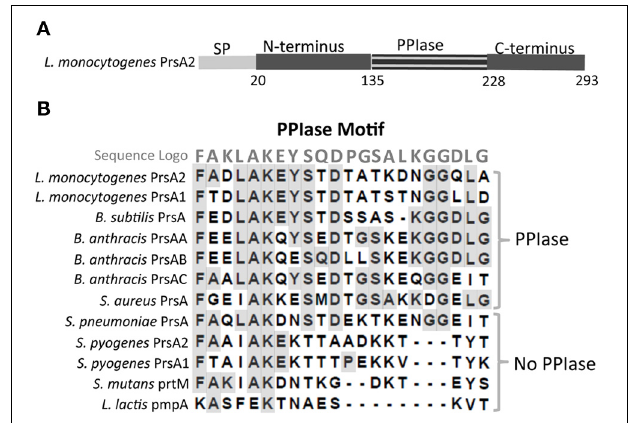
FIGURE 3 | L. monocytogenes PrsA2 domain organization and the comparative alignment of PPIase domains of Gram-positive bacteria. (A) Shown are the N-terminal signal peptide, N-terminus, PPIase domain, and C-terminus where numbers designate amino acids. (B) An alignment of the PPIase domain of 12 PrsA-like homologs is shown. The sequence logo is also indicated where identical amino acids are highlighted in gray. Homologs having a PPIase or no PPIase motif are